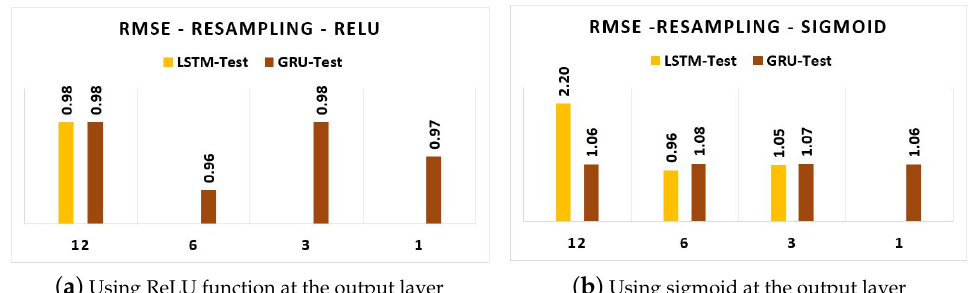
Figure 13. RMSE value for LSTM and GRU model with ReLU and sigmoid at the output layer, for different undersampling rates: using one data point per 12 h, one per six hours, one per 3 h, and one per hour.